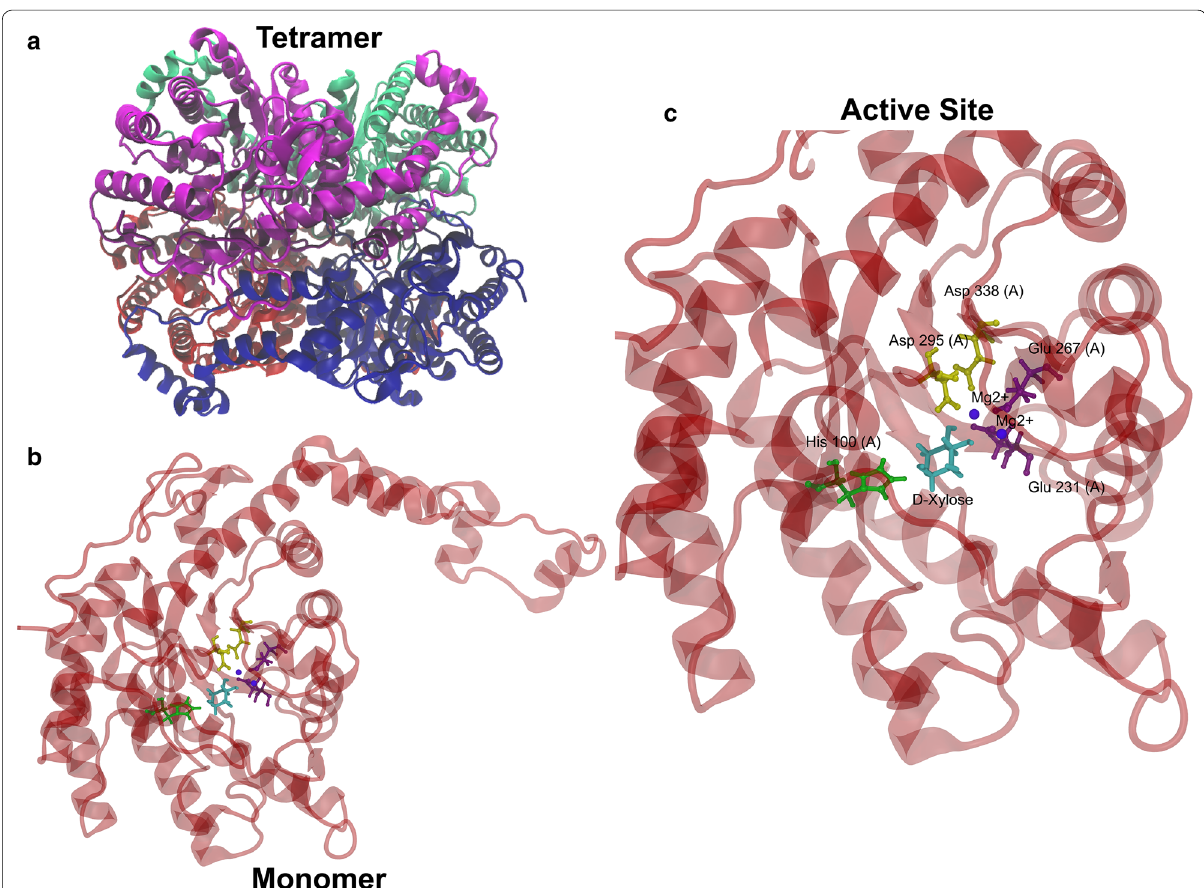
Fig. 3 Xylose isomerase from B. cenocepacia predicted structure. a Overall structure of XylA Bc as a tetramer. b Monomer structure of XylA Bc . c Active site